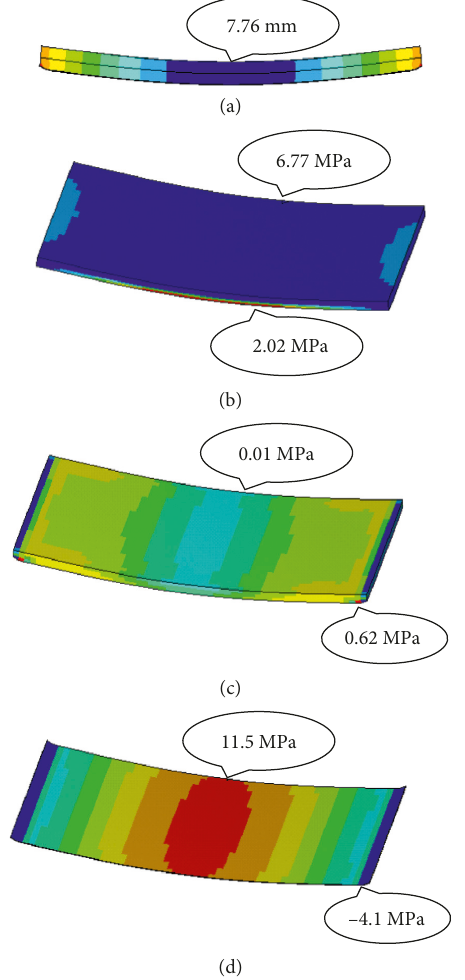
Figure 7: Results of static analysis: (a) structural displacement; (b) stress in the recycled aggregate concrete layer; (c) stress in the EPS core; (d) stress in the GFRP skin.